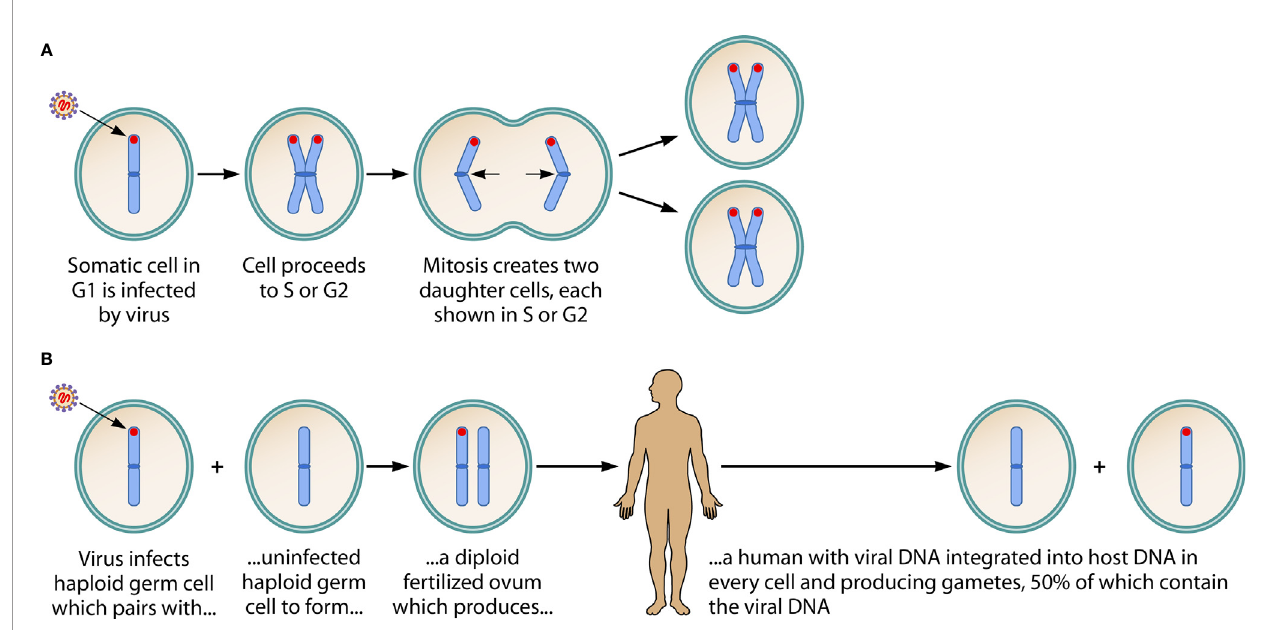
FIGURE 1 | Consequences of HHV-6A/B DNA integration into a chromosome of a somatic cell, and into the host chromosome of a germ cell. (A) Shows acquired virus integrating its DNA (in red) into the telomere of a chromosome of a somatic cell. It has been hypothesized that this is a mechanism by which HHV-6A/B achieves latency. Since the viral genome is not integrated into the DNA of sperm or ova, no vertical transmission of the viral genome occurs. (Note: This fi gure shows only one of the 23 chromosomes, in early metaphase, and assumes viral infection and integration occurs in the G1 phase, then is replicated in the S phase and passed to both of the daughter cells during mitosis. When the integration event occurs during S or G2 phases — not shown in the fi gure — the daughter cells create a mosaic, since one contains the viral genome and the other does not.) (B) Describes an ancient event: on several occasions in human history, the viral genome integrated into the DNA of a haploid germ cell chromosome. This led to a fertilized ovum containing the viral genome and, hence, to a human with the viral genome integrated into a chromosome in every cell: inherited chromosomally-integrated HHV-6 (iciHHV-6). In Mendelian fashion, the integrated viral DNA is present in 50% of gametes (whether sperm or ova). About 1% of humans are born with iciHHV-6. The inherited presence of the viral genome in every cell, including germ cells, contrasts with the integration of acquired virus into only a small fraction of target somatic cells. Adapted from, and reprinted with permission of the publisher, from: Komaroff AL, Pellett PE, Jacobson S. Human herpesvirus 6A and 6B in brain diseases: Association vs. causation. Clinical Microbiology Reviews. 2021; 34:e00143- 20.